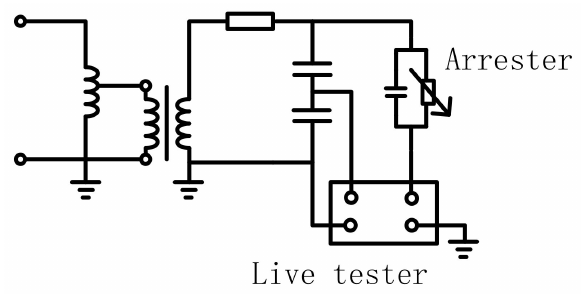
Figure 3. Leakage current test circuit under continuous operation